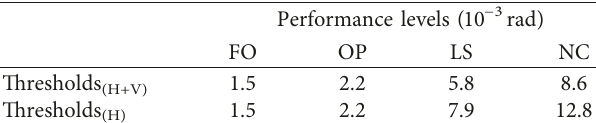
Figure 10: Capacity curves without considering the vertical seismic effect. (a) Site I. (b) Site II. (c) Site III. (d) Site IV. Table 8: Thresholds of performance